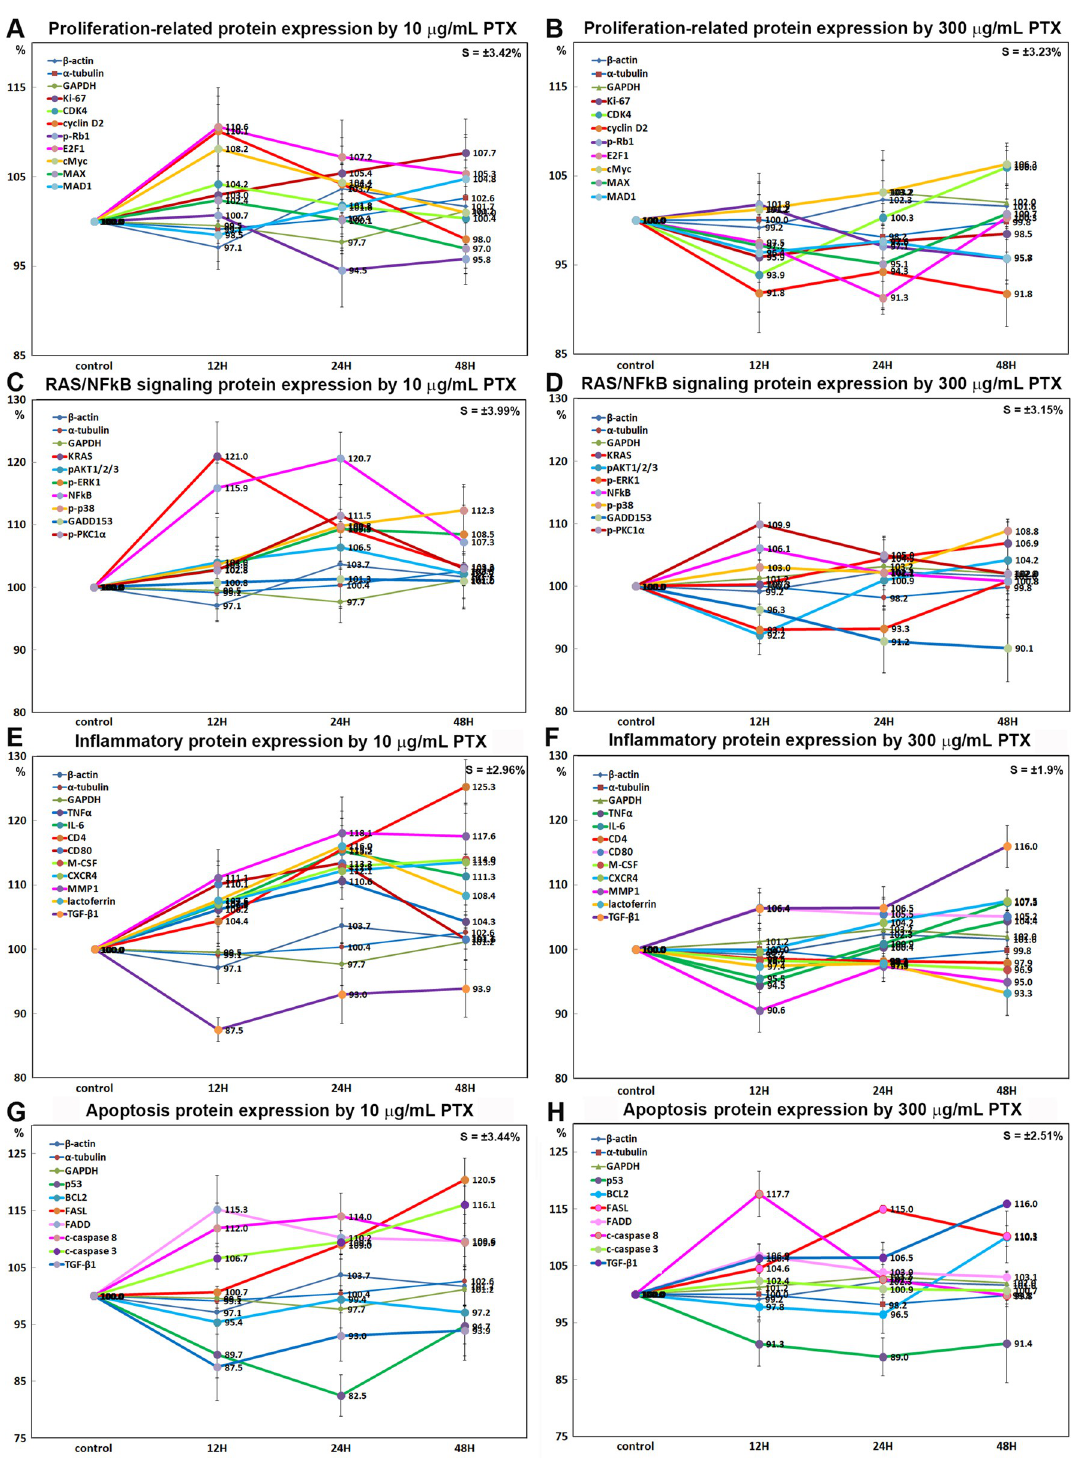
Fig 17. IP-HPLC comparison between the protein expression of 10 μ g/mL and 300 μ g/mL PTX-treated RAW 264.7 cells. Expression of proliferation-related proteins (A and B), RAS/NFkB signaling proteins (C and D), inflammatory proteins (E and F), and apoptosis proteins (G and H) as determined by IP-HPLC. Line graphs, A, C, E, and G show 10 μ g/mL PTX-induced protein expressions, whereas B, D, F, H show 300 μ g/mL PTX-induced protein expressions on the same scale (%) versus culture time (12, 24, or 48